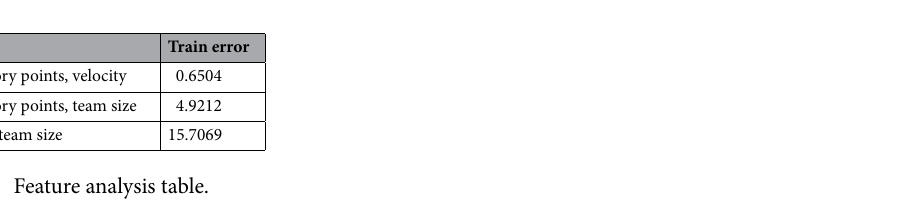
Table 3. Feature analysis